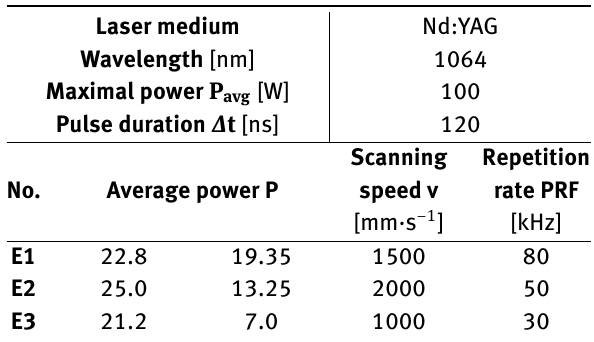
Table 2: Technological parameters used in production of surface textures on the sample I.